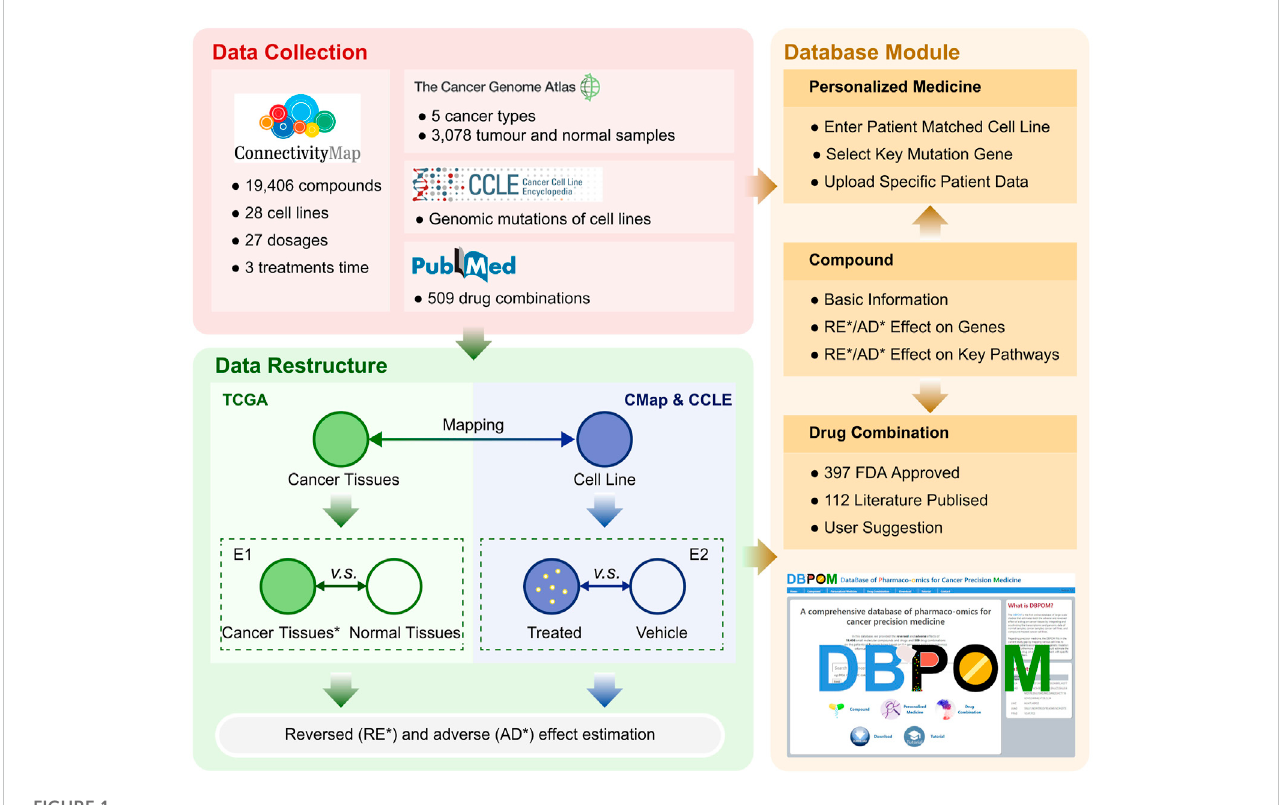
FIGURE 1 The overall framework includes the methods and DBPOM.